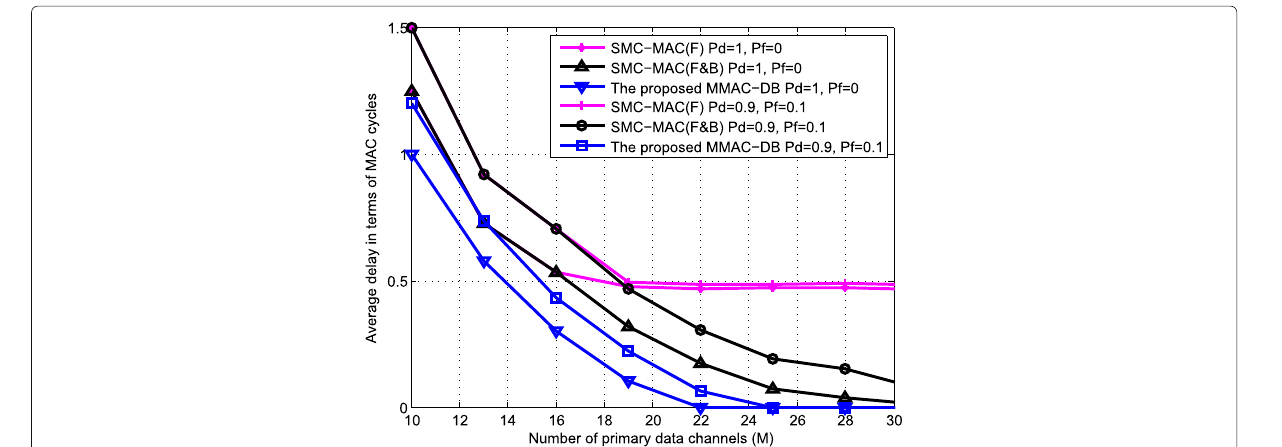
Fig. 10 Channel access delay comparison with varied M from 10 to 30, N = 20, α = 0.1. Channel access delay comparison for scene